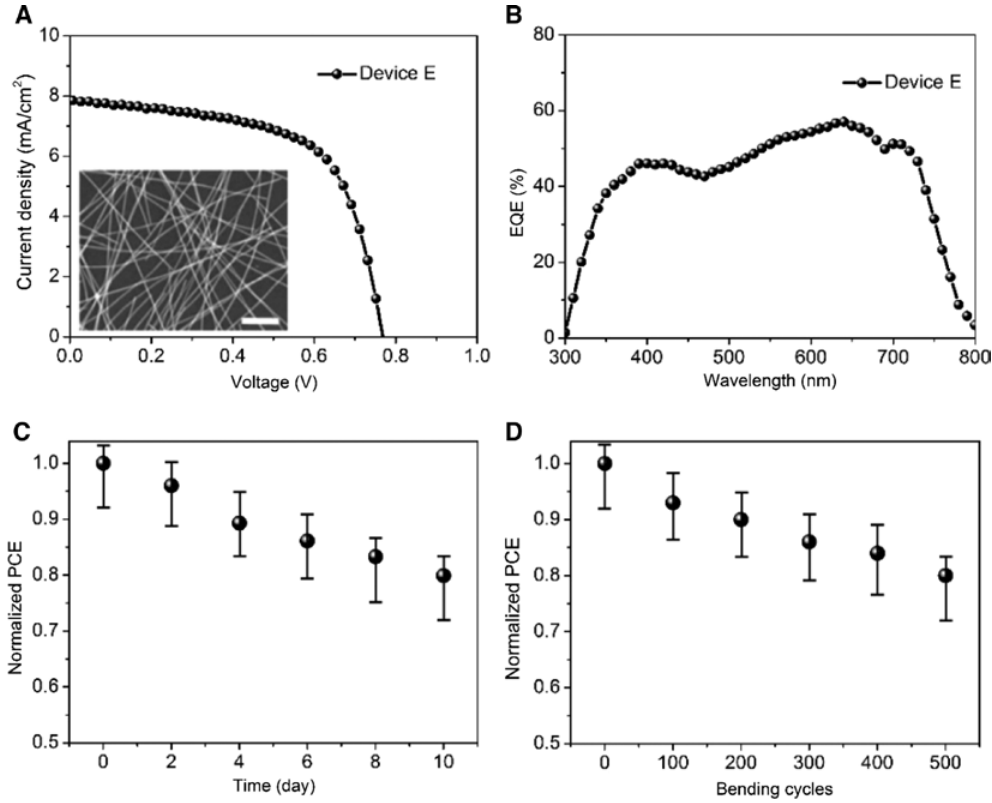
Figure 5: Device E